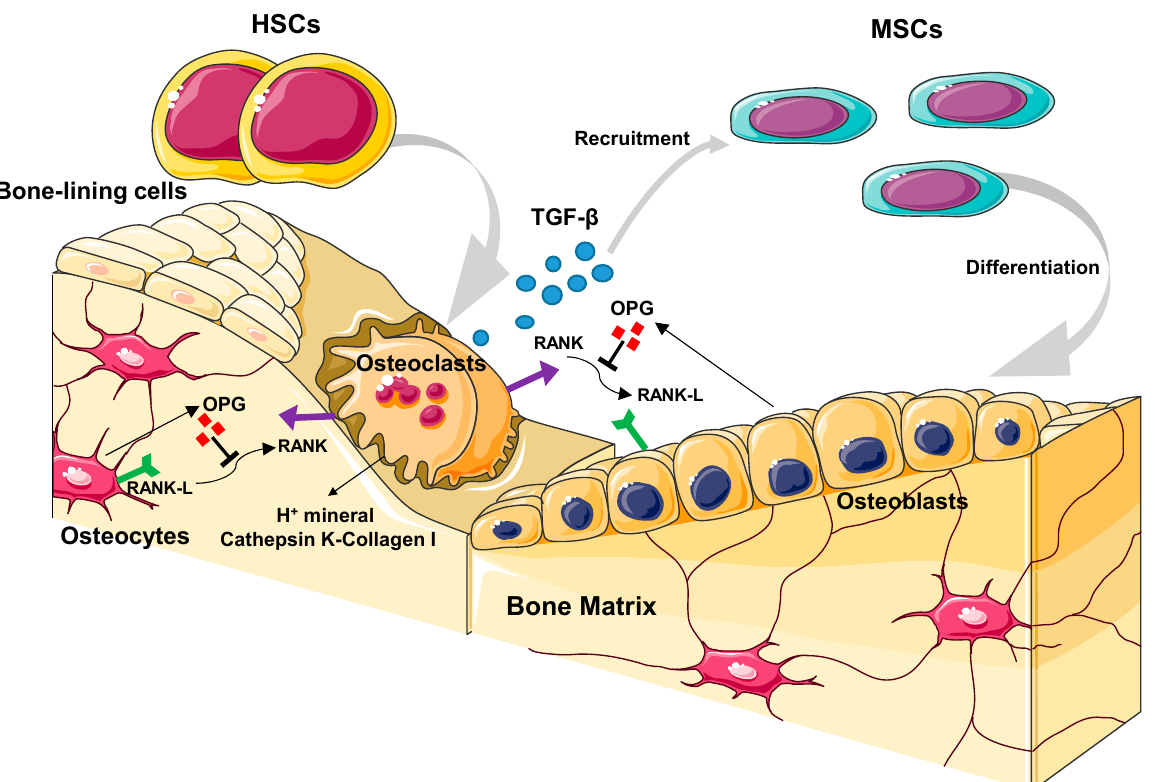
Figure 2. Representation of the different cell types involved in bone remodeling. The figure shows the most-relevant metabolic pathways involved in bone regeneration, both in bone-forming and bone-resorption surfaces. Abbreviations: mesenchymal stem cells (MSCs), hematopoietic stem cells (HSCs), osteoprotegerin (OPG), receptor activator of nuclear factor κ B (RANK), receptor activator of nuclear factor kappa B ligand (RANKL).